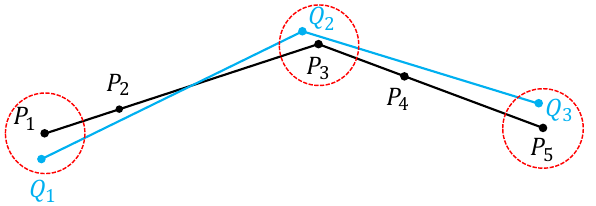
Figure 5. An illustration of two different representations of the same LineString